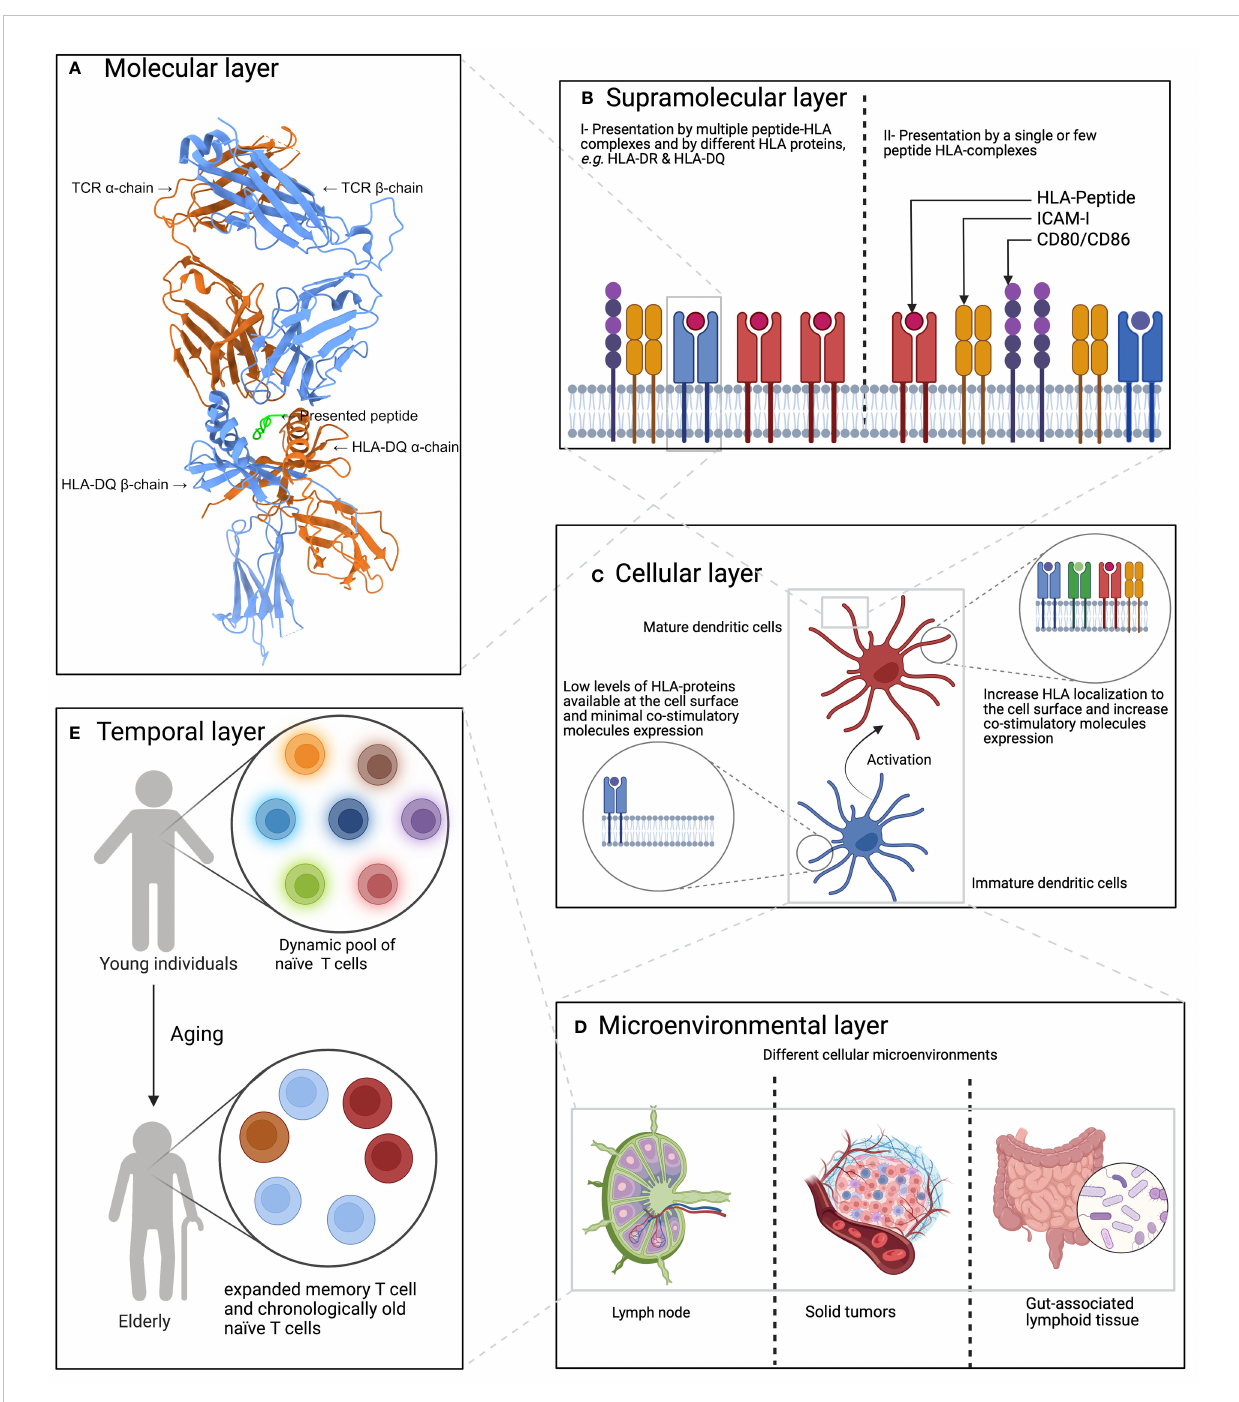
FIGURE 1 A hierarchal model of factors in fl uencing or shaping the T cell response. (A) The molecular layer which focuses on HLA-peptide-TCR interaction. Here, the interaction between HLA- DQ 2.2 loaded with a gluten-derived peptide and a TCR is shown. The panel was created using ChimeraX (55), the protein 3D structure was obtained from Protein Data Bank (56) under the identi fi er 6PX6 (57). (B) The supramolecular layer which describes the impact of co-stimulatory molecules and the count of HLA-P complexes, among others. (C) Describes the impact of the cell types on both sides of the immunological synapse, i.e. the type of APCs and T cells, on shaping the generated T cell response. (D) The CME layer which describes the impact of the cellular micro-environment on shaping T cell response where extra cellular signaling can in fl uence both antigen presentation, T cell priming and subsequently the generated T cell response. (E) The impact of aging on shaping T cell response where the T cell pool becomes dominated by expanded memory T cells and chronological old naïve T